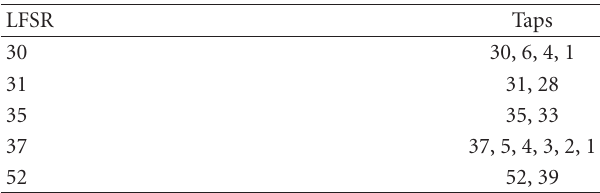
Table 1: LFSR taps.